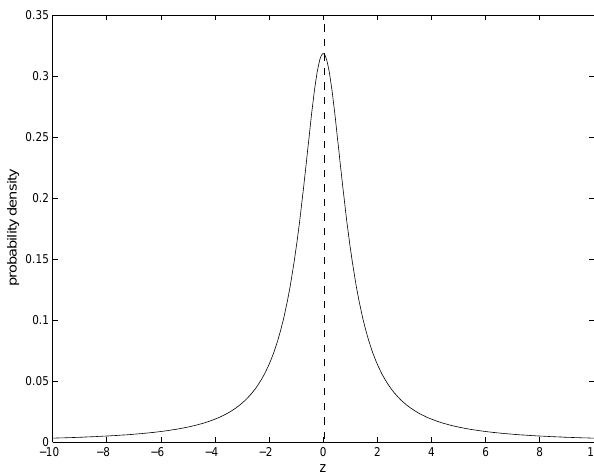
Fig. B1. Probability density function of the standard Cauchy distri- bution C( 0 , 1 )